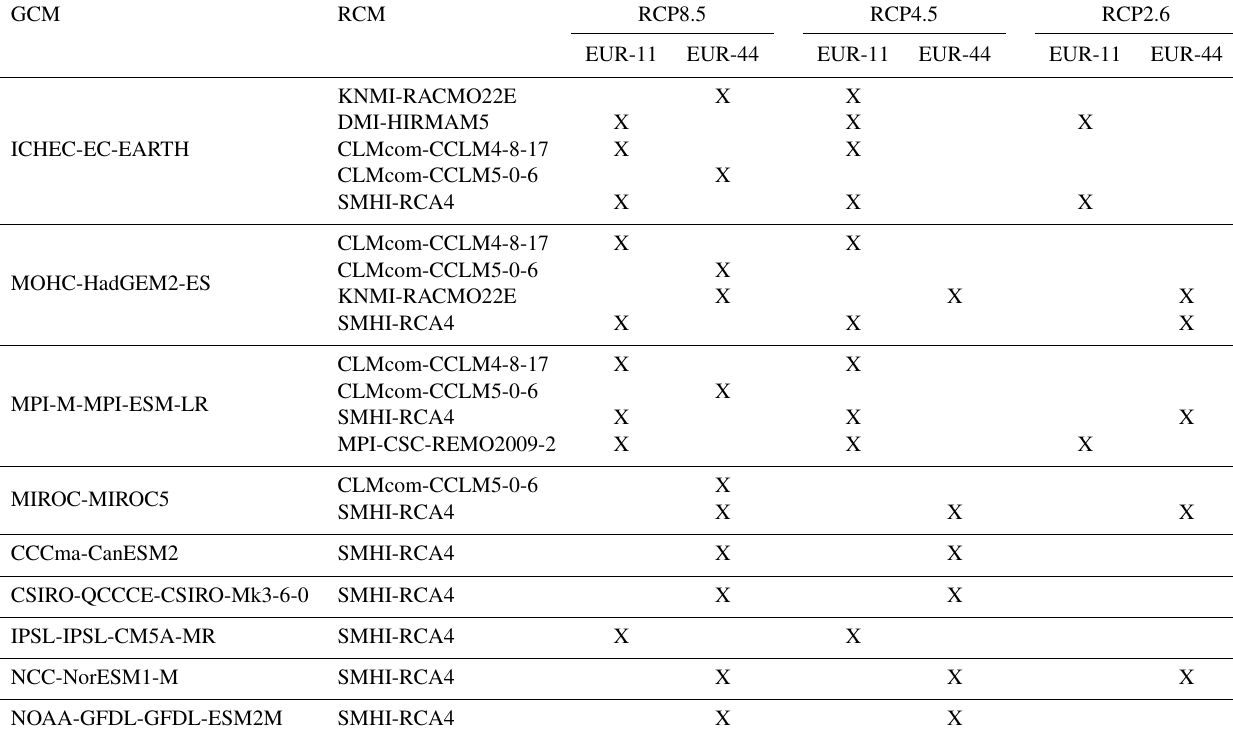
Table 1. List of GCM–RCM chains used, their initial resolution, and the RCP available.